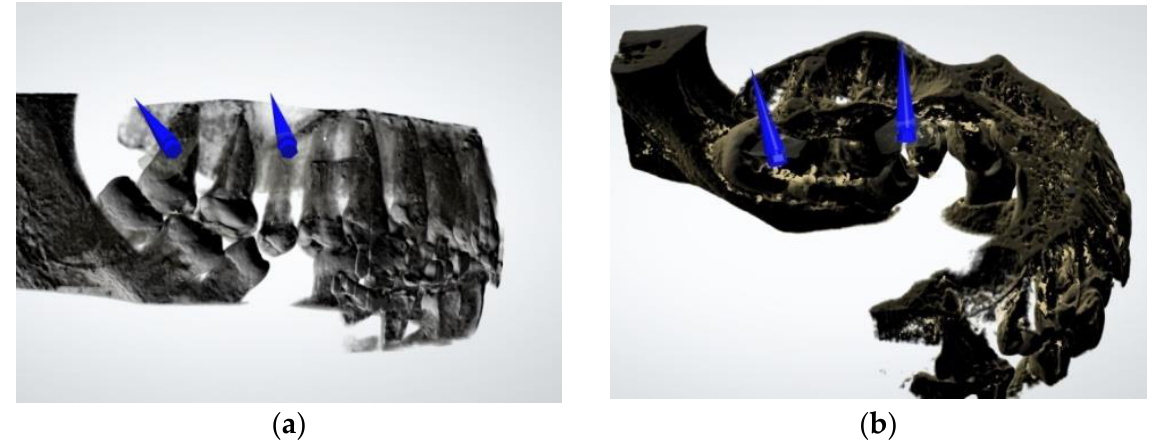
Figure 4. Preoperative surgical planning: ( a ) Buccal miniscrews; ( b ) Palatal miniscrews. The TADs were inserted using the NSK Surgical Pro Fiziodispenser and NSK Ti-Max Contra Angle Handpiece (20:1 Reduction), using a rotation speed of 30 rpm and a 30 N/cm